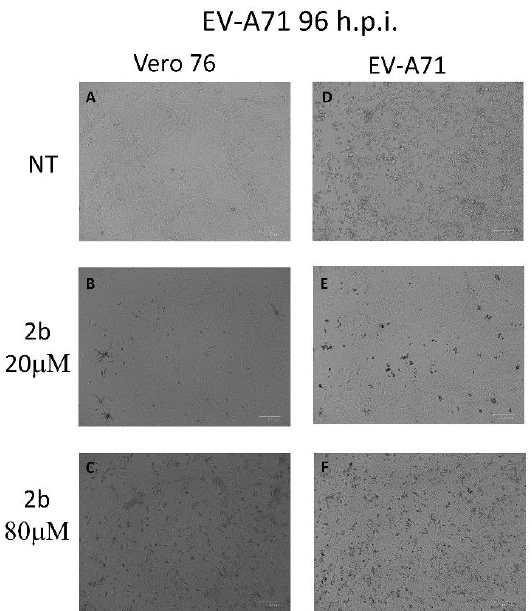
Figure 1. Effect of 2b inhibitor (20 and 80 µM) on the Vero-76-infected monolayers. Control (1 A ), treated cells with 20 µM ( B ), treated cells with 80 µM ( C ), infected cells ( D ), infected treated cells post-infection using ZOE Fluorescent cell imager (Bio-Rad) (bar size = 100 µ m, magnification, 20 × (20 µM) ( E ), and infected treated cells (80 µM) ( F ). Pictures of cell morphology were taken at 72 h post-infection using ZOE Fluorescent cell imager (Bio-Rad) (bar size = 100 μm, magnification, 20 ×).